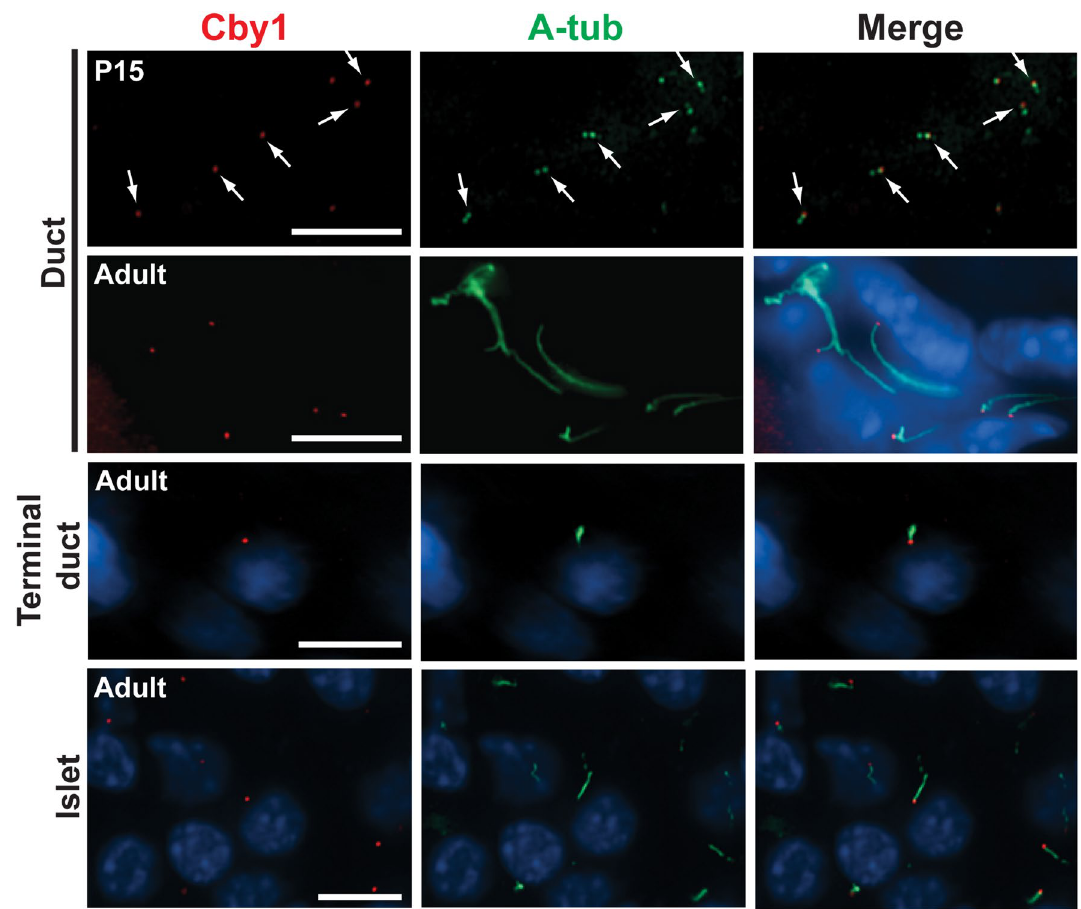
Figure 5. Localization of Cby1 in the pancreas. Pancreatic sections from P15 and adult mice were immunostained with antibodies against Cby1 (red) and acetylated α-tubulin (A-tub) (green). Nuclei were detected with DAPI (blue). In undifferentiated ductal cells at P15, which had not yet elongated primary cilia, Cby1 localized to only one of the two centrioles (arrows). In the adult pancreas, intense Cby1 signals were seen at the base of primary cilia in ductal, terminal ductal, and islet β-cells. Scale bar, 10